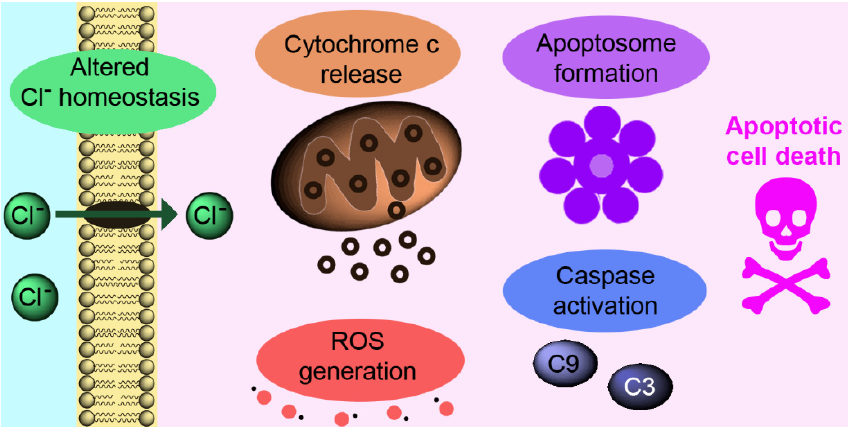
Figure 4. Schematic representation of caspase-mediated apoptosis. Table 2. Cl − selective artificial channels recently developed to induce apoptosis as anticancer agents.